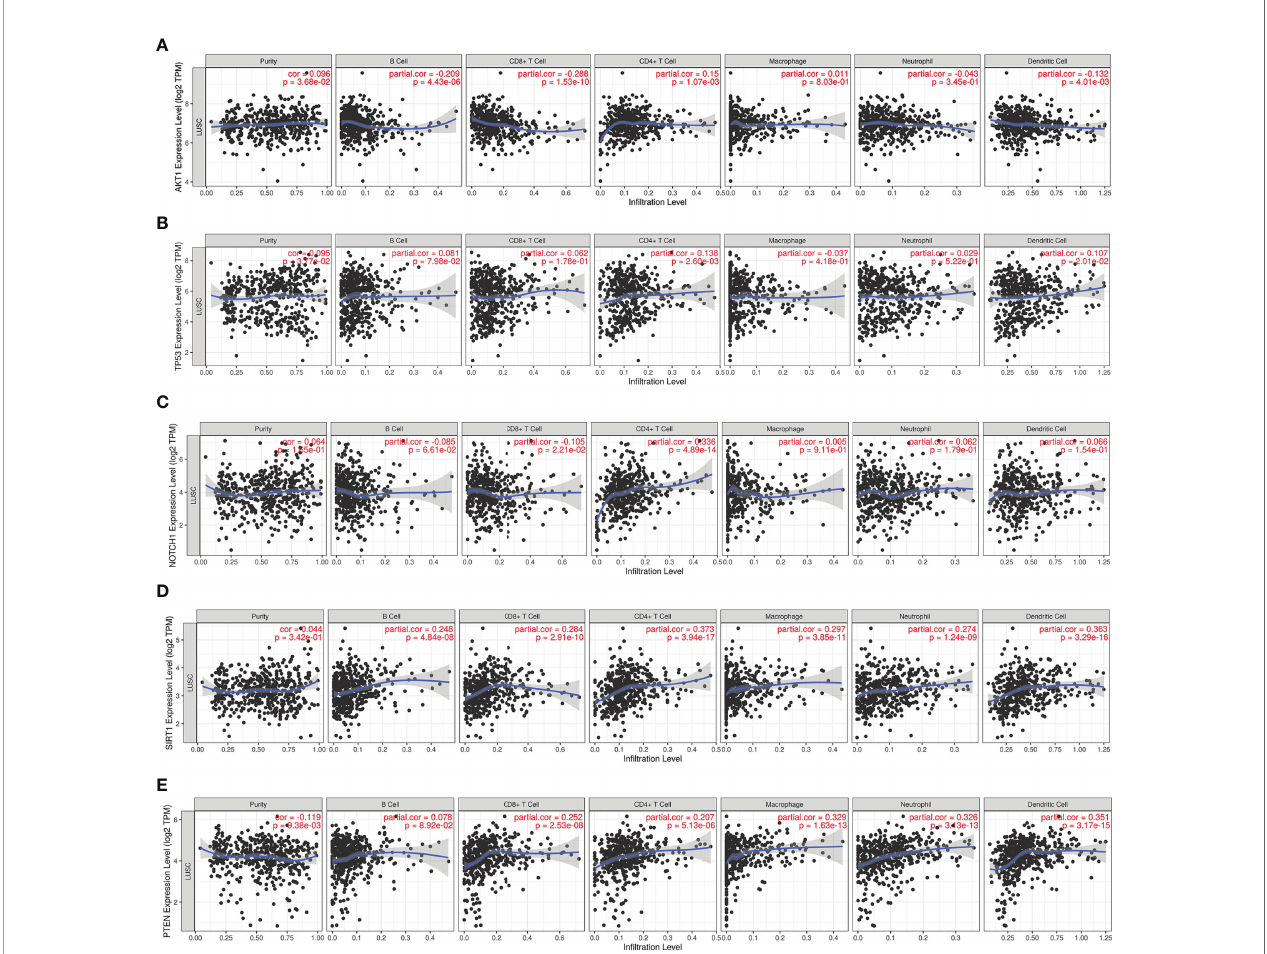
FIGURE 7 | Correlations between the 5 core target genes and immune in fi ltration level in LUSC were analyzed using TIMER database. (A) AKT1, (B) TP53, (C) NOTCH1, (D) SIRT1, (E)